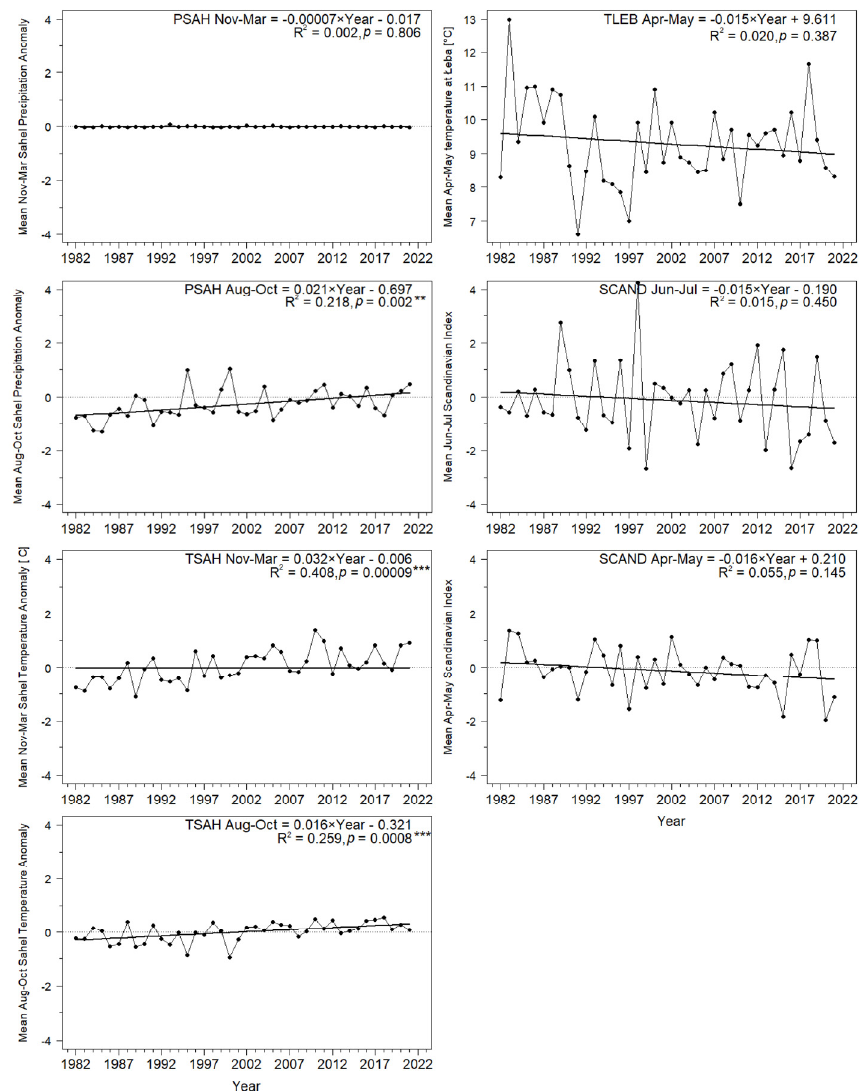
Figure 5. Trends and variation for the climate indices used in the study over 1981–2021. Year is used in the equations as the explanatory variable. Statistical significance of the regression equations: * 0.05 < p < 0.1, ** p < 0.01, *** p <